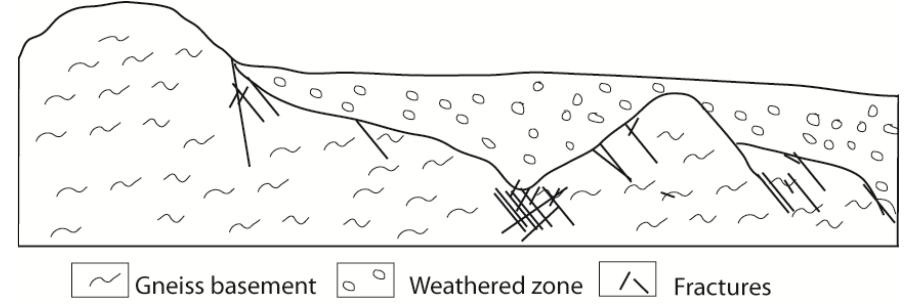
Figure 2. Conceptual geological model of the study area in W-E direction.